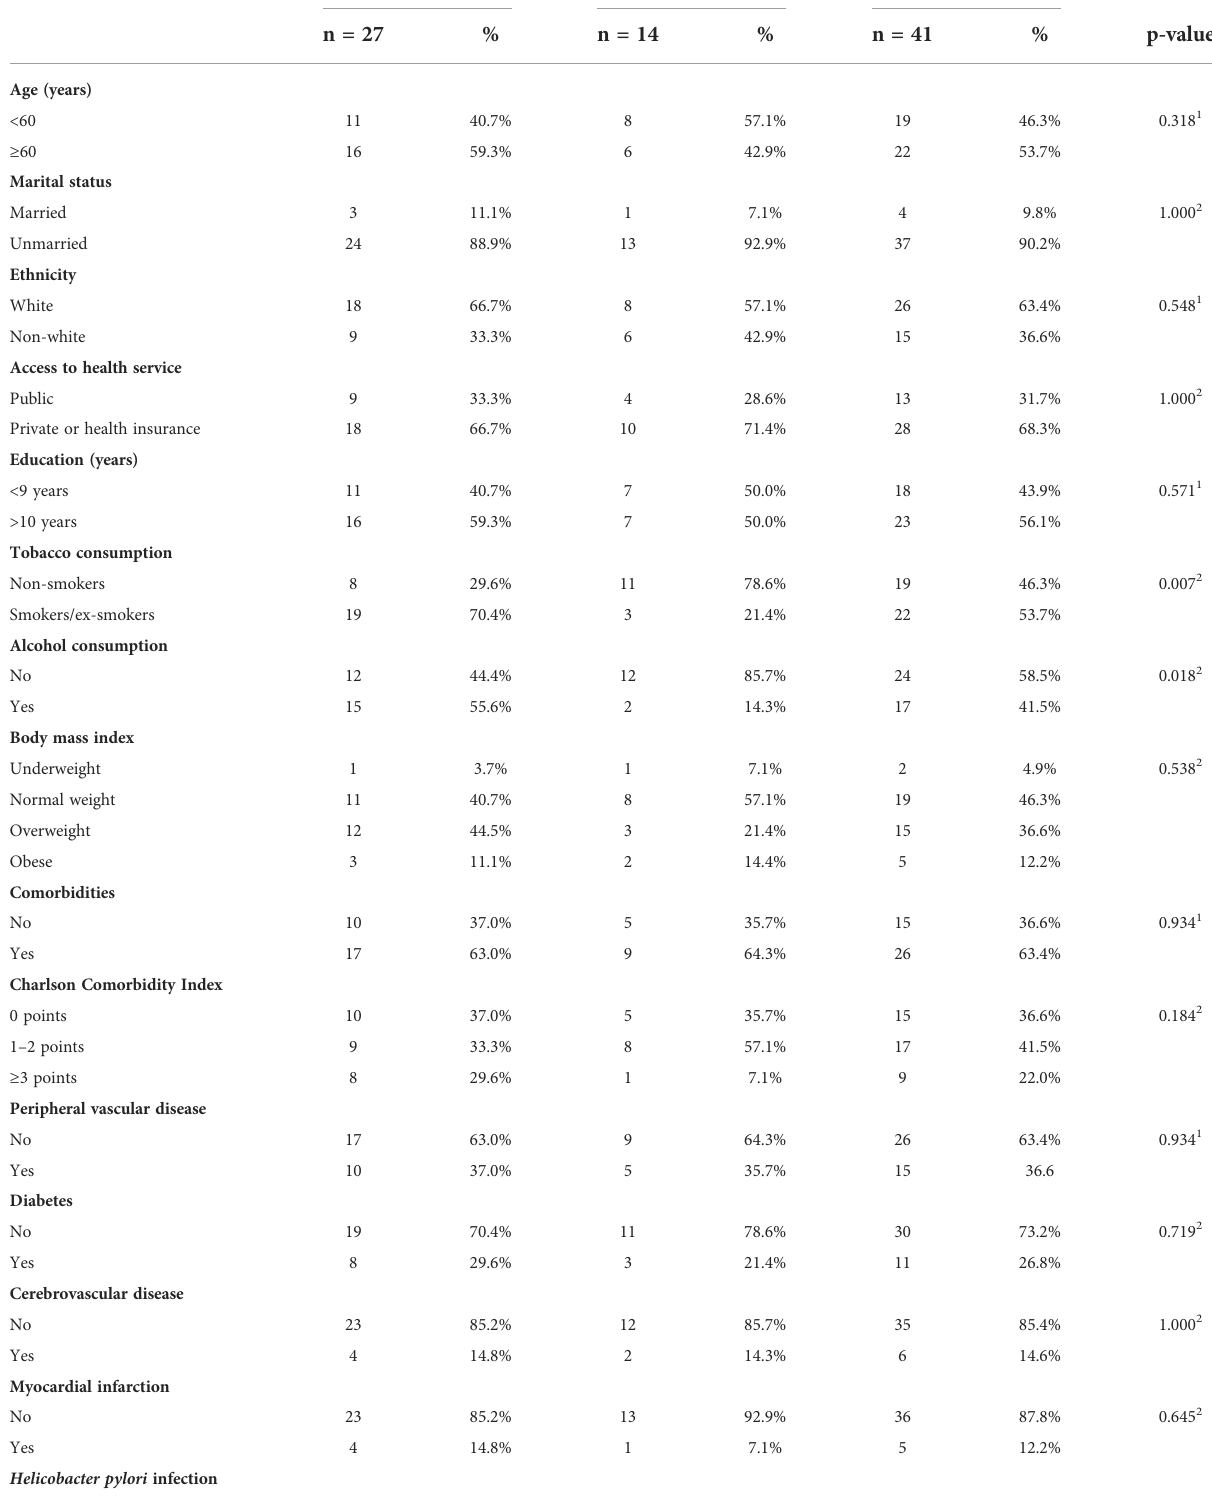
TABLE 4 Sociodemographic, lifestyle, and clinical characteristics of 41 patients with gastric adenocarcinoma who died in the fi rst year of follow- up, by sex. Male